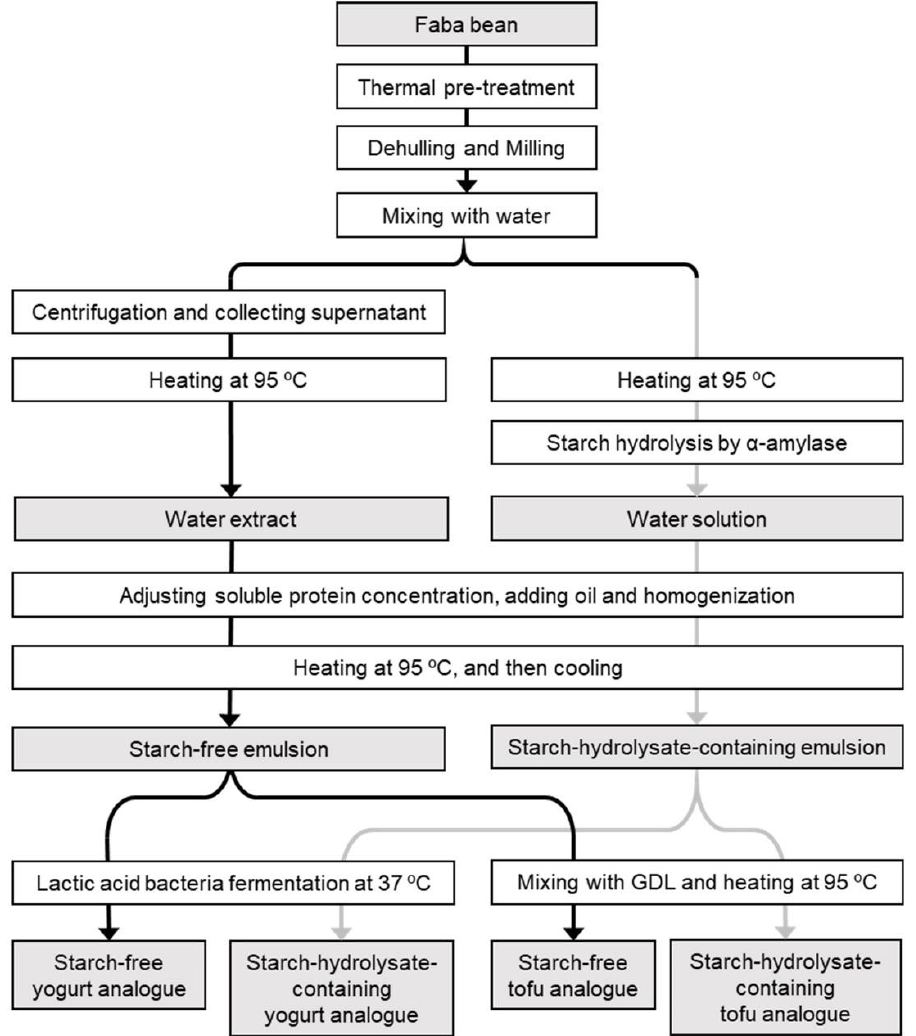
Figure 1. Flow chart of the production methods for faba bean starch-free yogurt analogue, starch-hydrolysate-containing yogurt analogue, starch-free tofu analogue and starch-hydrolysate-containing tofu analogue. GDL, glucono-delta-lactone.